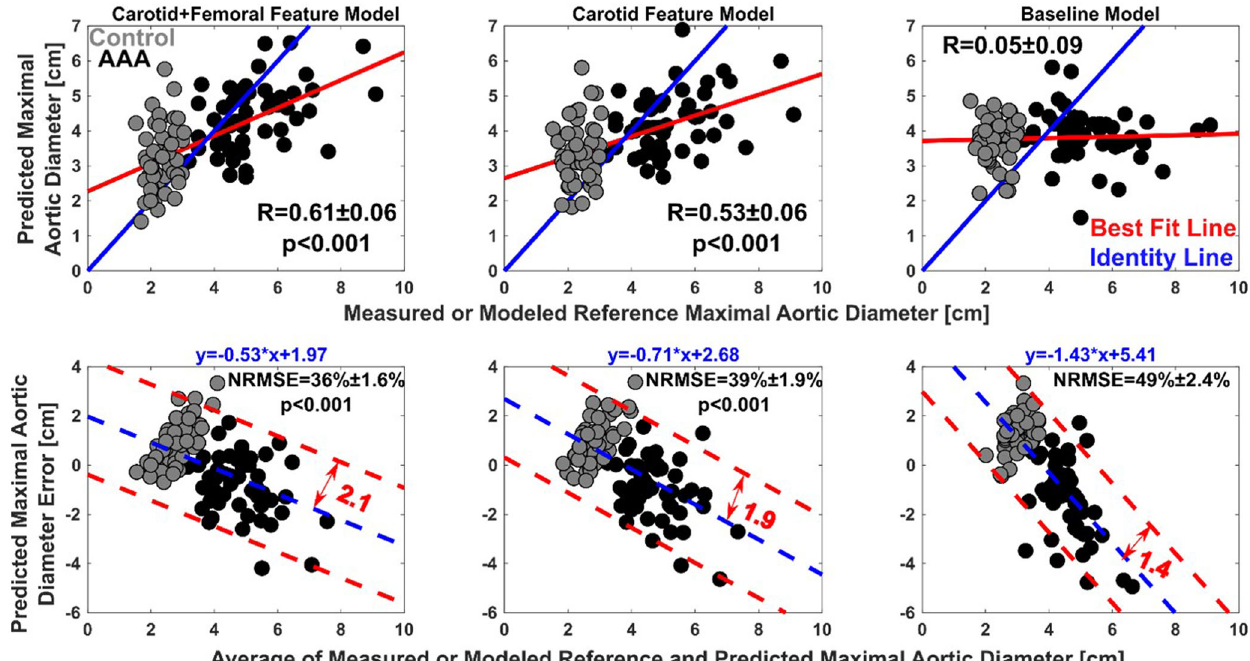
Fig. 5 Accuracy results of the 100 leave-one-patient-out maximal aortic diameters predicted by the three models (see optimal yet representative Eqs. (1 – 3)) for the 100 AAA (before EVAR) and control patients. Correlation plots (top) are predicted versus measured or modeled reference maximal aortic diameters. R (mean ± s.e.m) is correlation coef fi cient. The two-sided p-values were obtained through comparisons with the baseline model using a common test for dependent data 12 . Bland-Altman plots (bottom) are predicted maximal aortic diameter errors versus the average of the predicted and measured or modeled reference maximal aortic diameters. NRMSE (mean ± s.e.m) is the overall normalized-root-mean-squared-error in percent. The two-sided p -values were obtained through comparisons with the baseline model using nonparametric bootstrapping for paired data. The black datapoints denote AAA patients with measured reference maximal aortic diameters, while the gray datapoints indicate control patients with modeled reference maximal aortic diameters (see text for